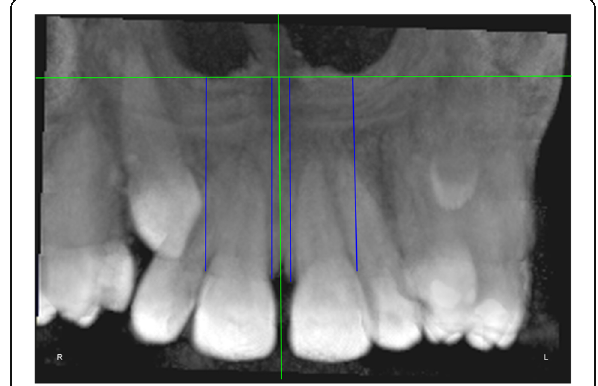
Fig. 1 Anterior alveolar ridge height. Measured in millimeters from the bony ridge of upper incisors by drawing a straight line parallel to the midsagittal plane till the floor of the nostrils on the side of the impacted canine and the side without impaction